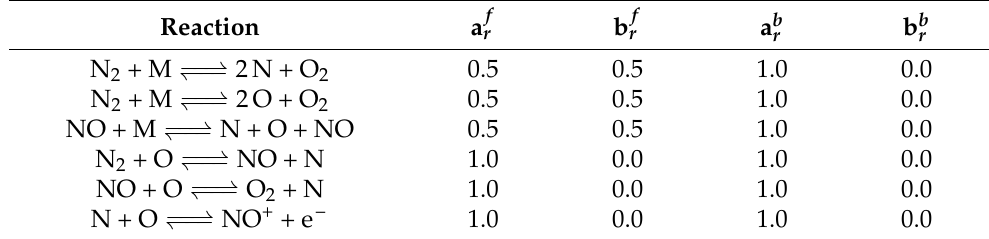
Table A2. Reaction rate coefficient controlling temperature factors.